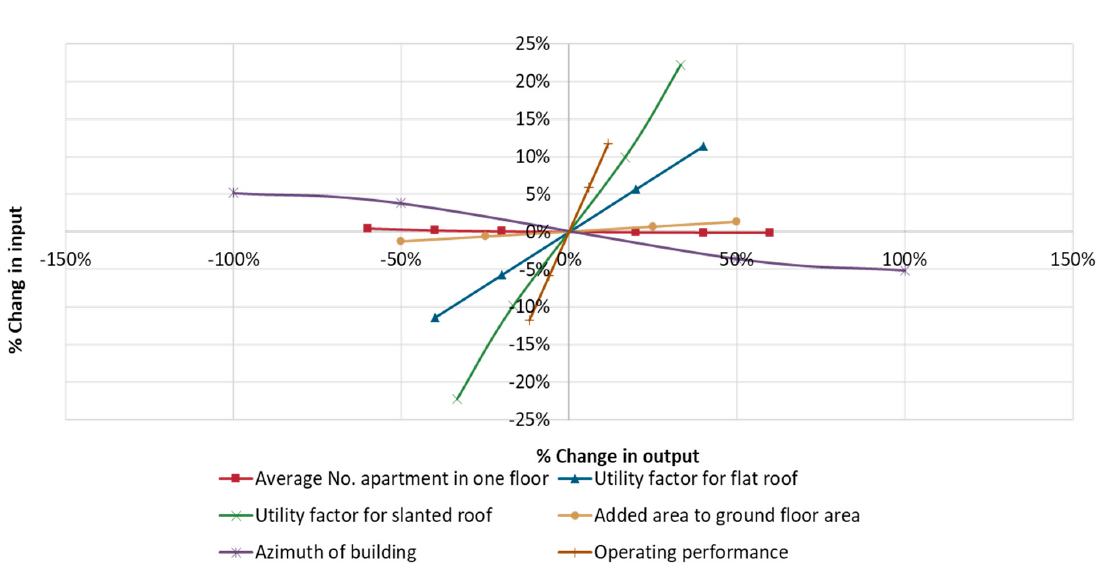
Figure 8. Sensitivity analysis of input variation effect on technical potential output.